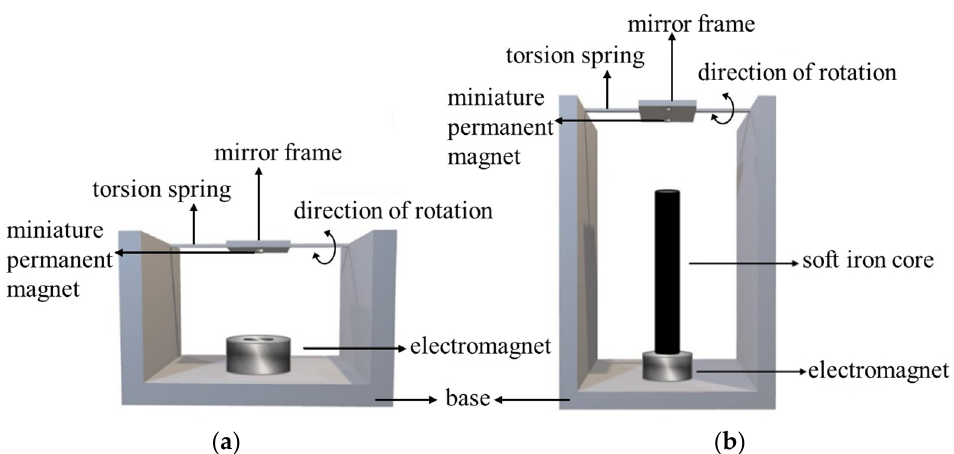
Figure 2. Two practical arrangements: ( a ) Type I without the soft iron core for extension; ( b ) Type II with the soft iron core for extension.